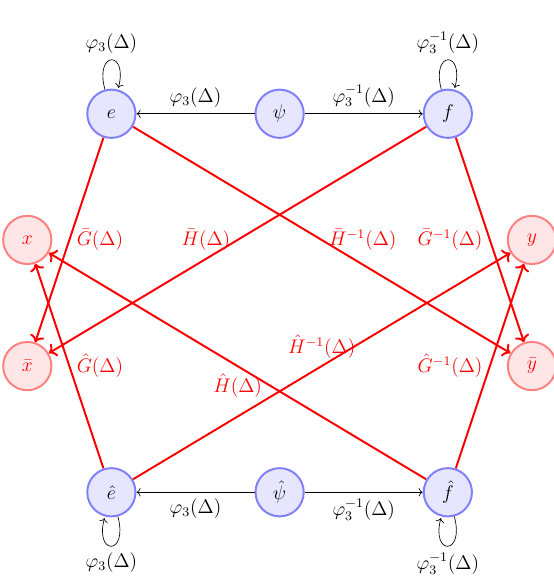
Figure 5 . The OPE relations of the unhatted (cid:12)elds with (cid:22) x and (cid:22) y , and those of the hatted (cid:12)elds with x and y